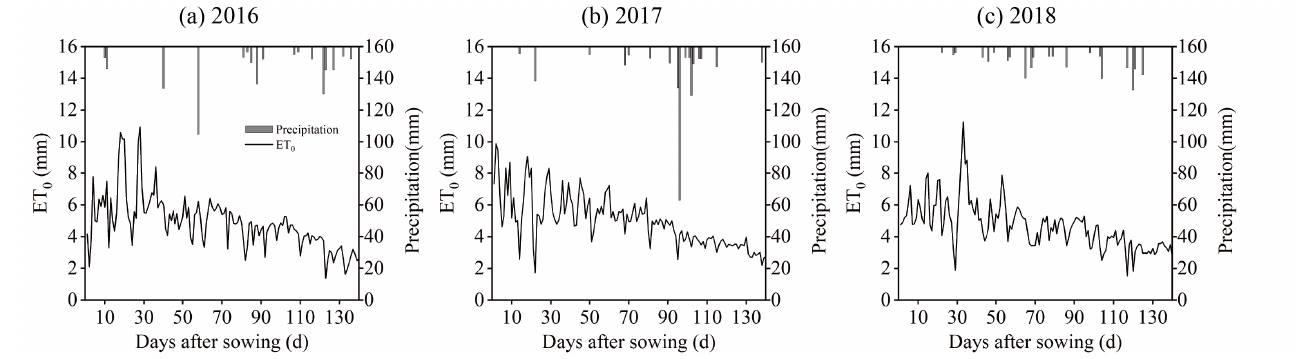
Figure 2. Precipitation and reference crop evapotranspiration ( ET 0 ) during the maize growing seasons. ( a ) 2016. ( b ) 2017. ( c )